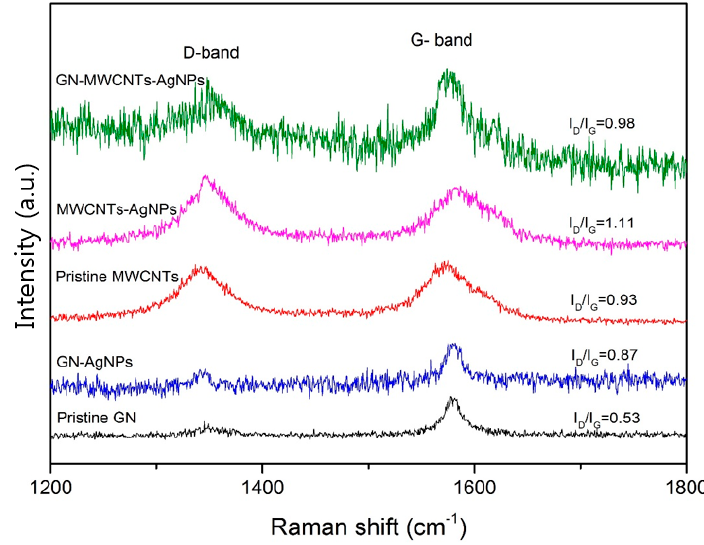
Figure 6. Raman spectra of the pristine GN, pristine MWCNTs, GN-AgNPs, MWCNTs-AgNPs and GN-MWCNTs-AgNPs.